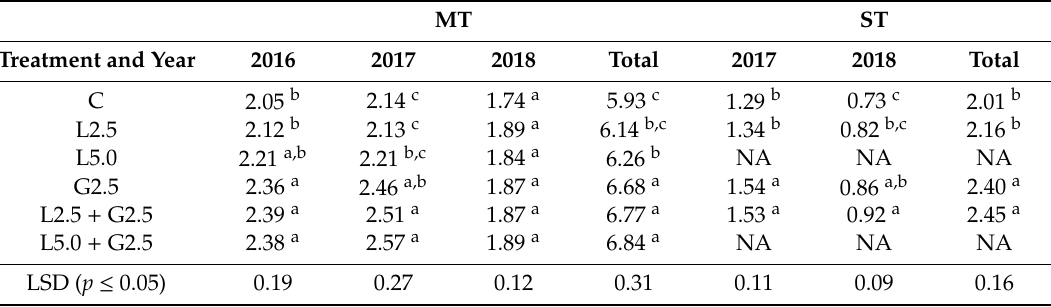
Table 3. Grain yields (t ha − 1 ) of canola in 2016, wheat in 2017, and barley 2018, observed at the MT (3 growing seasons, 2017–2018), and the ST (2 growing seasons, 2016–2018) experiments. The total represents the sum of the grain yields over the study period. Treatments were applied once on 31 July 2015 for the MT experiment, and 31 March 2017 for the ST experiment. Treatments included control